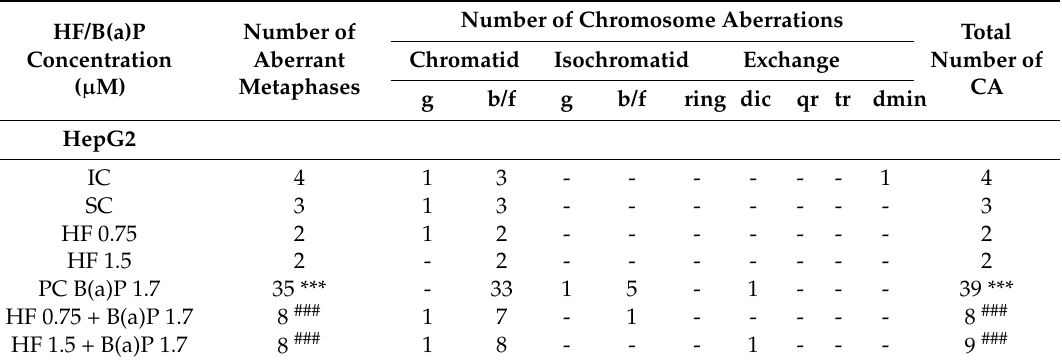
Table 1. Determination of HF anticlastogenic effect towards benzo(a)pyrene using the chromosome aberration test on HepG2 cells.